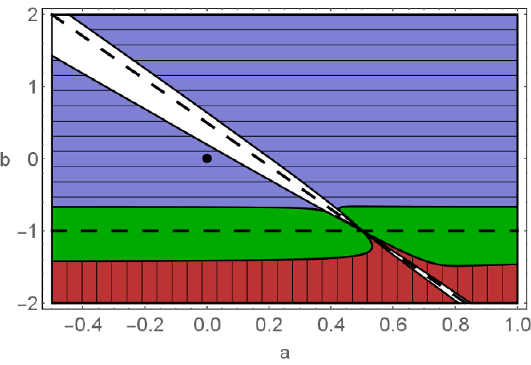
Figure 6 . Combined plot showing the regions where the quantum gravitational contribution to gauge and Yukawa interactions is antiscreening. The red region (with vertical lines) corresponds to the sub-space of higher-curvature couplings where only f y > 0 can be achieved. The blue region (with horizontal lines) indicates values of higher-curvature couplings where only f g > 0 holds. In the green region, f g > 0 and f y > 0 both hold. The dashed lines indicate the poles 1 + b = 0 (TT-mode) and 1 (cid:0) 6 a (cid:0) 2 b = 0 ( (cid:27)